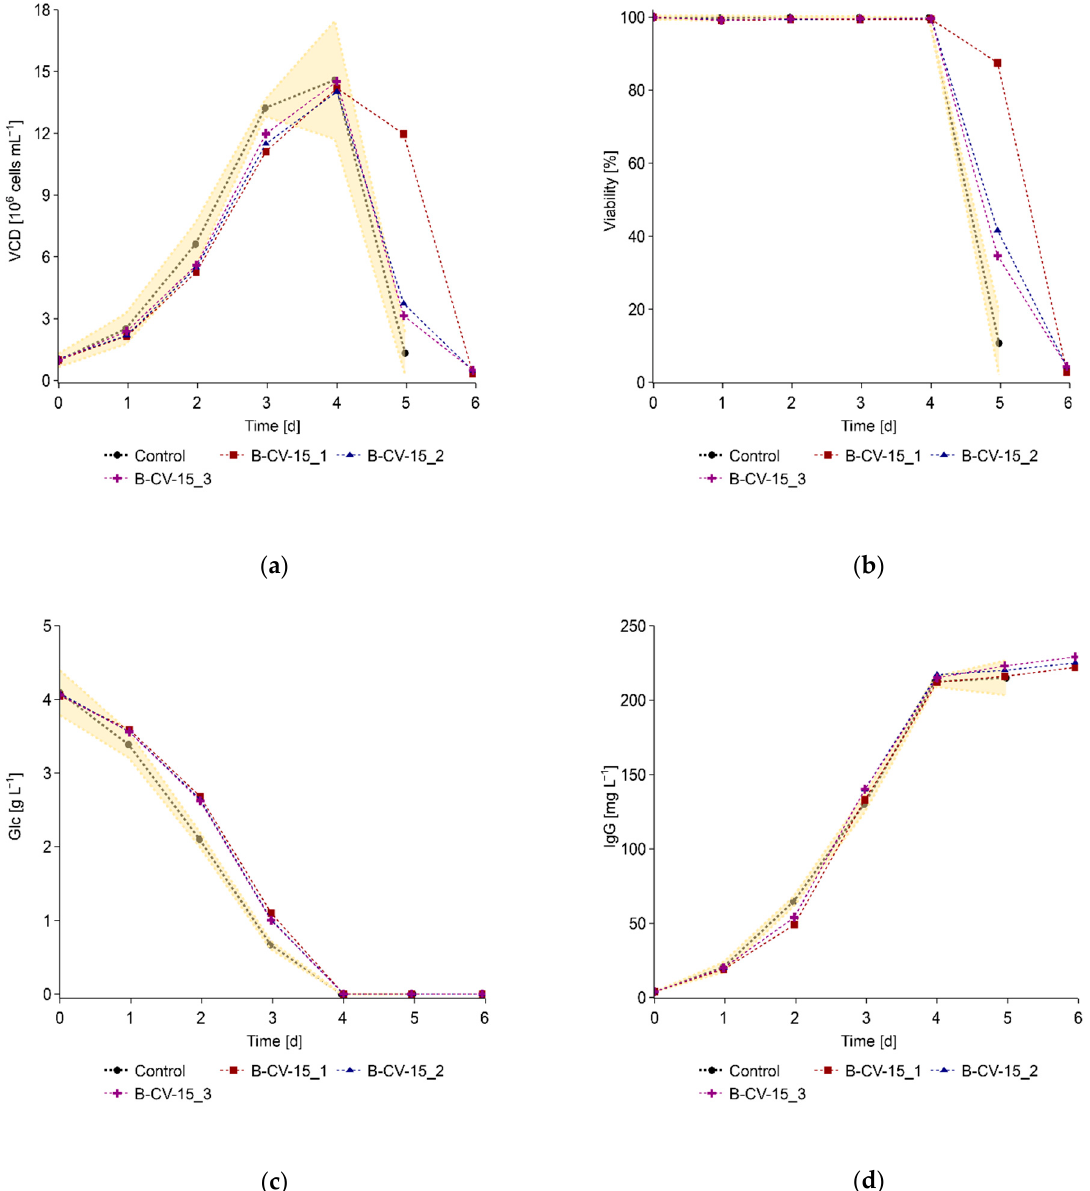
Figure 3. Course of ( a ) VCD, ( b ) viability, ( c ) glucose (Glc), and ( d ) IgG concentration during the batch experiments inoculated directly from cryovials (nomenclature: B = Batch, CV = inoculated out of cryovial, 15 = VCD in cryovial (×10 6 cells mL − 1 )). Control: batch experiments with standard inoculum production ( n = 3).